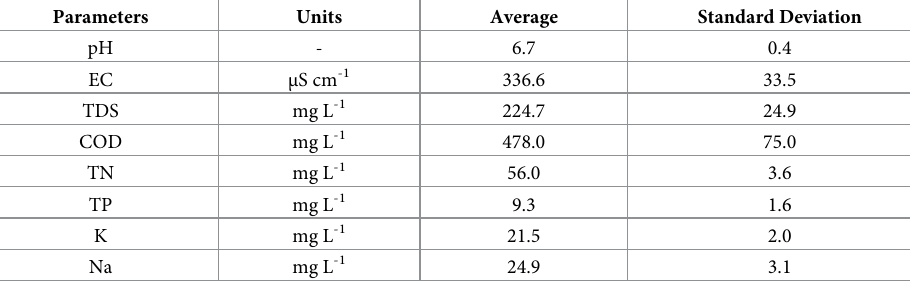
Table 3. Parameters of the synthetic municipal wastewater